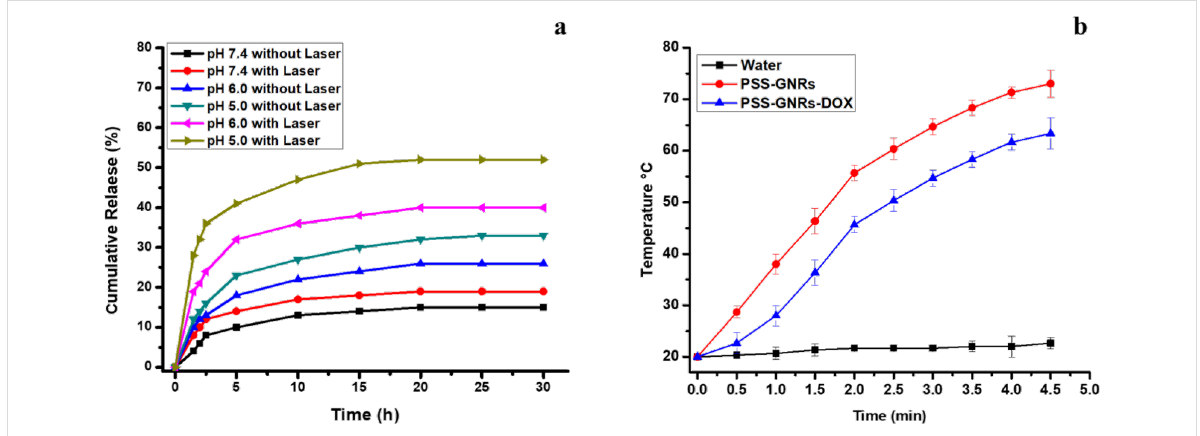
Figure 3: In vitro DOX release profile from PSS-GNRs. (a) NIR-triggered DOX release at different pH values. Fluorescence intensity was measured from 0 to 30 h. (b) Heating curves of water, PSS GNRs and PSS-GNRs-DOX (10 µg Au/mL) under NIR (808 nm) laser irradiation.